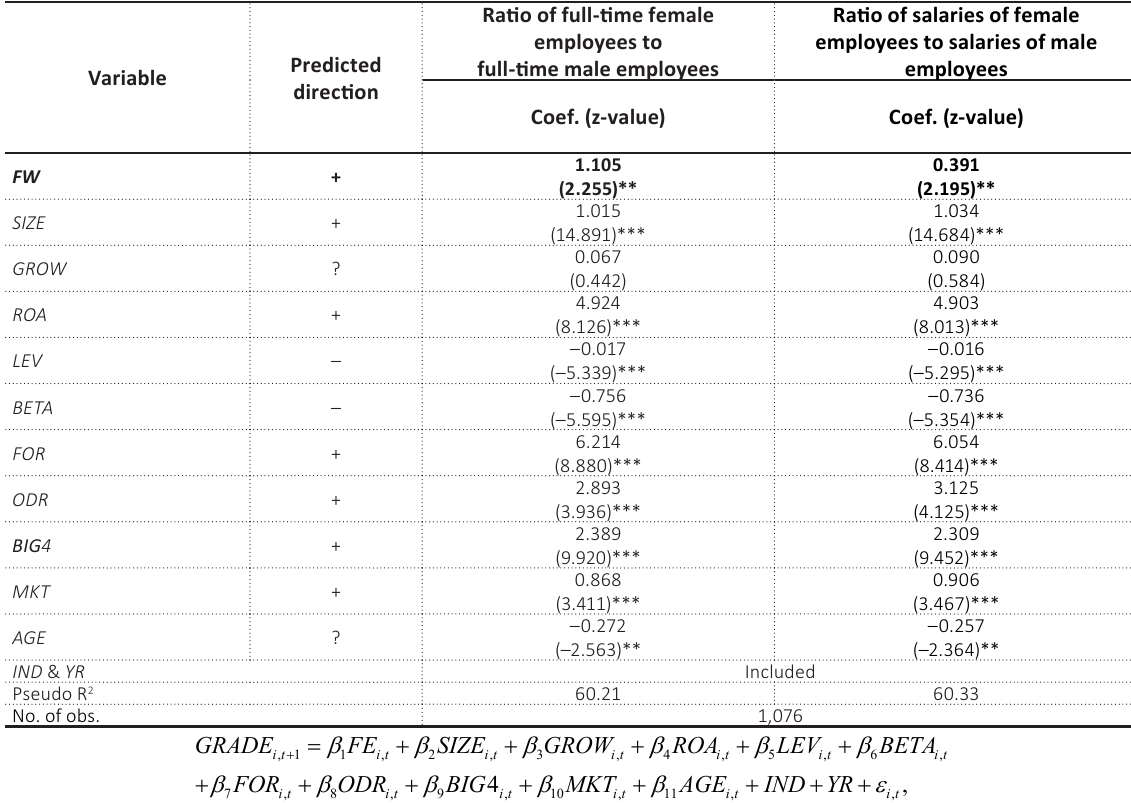
Table 3. Additional review of the effect of female employees on corporate credit